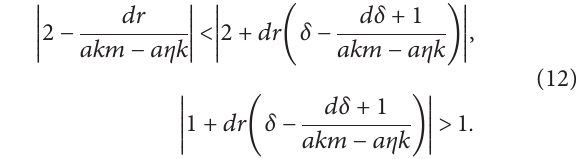
� 1 − r , λ � e b , and λ Here, λ 1 2 ) and λ eigenvalues of V ( E always lies outside the unit disk. 1 2